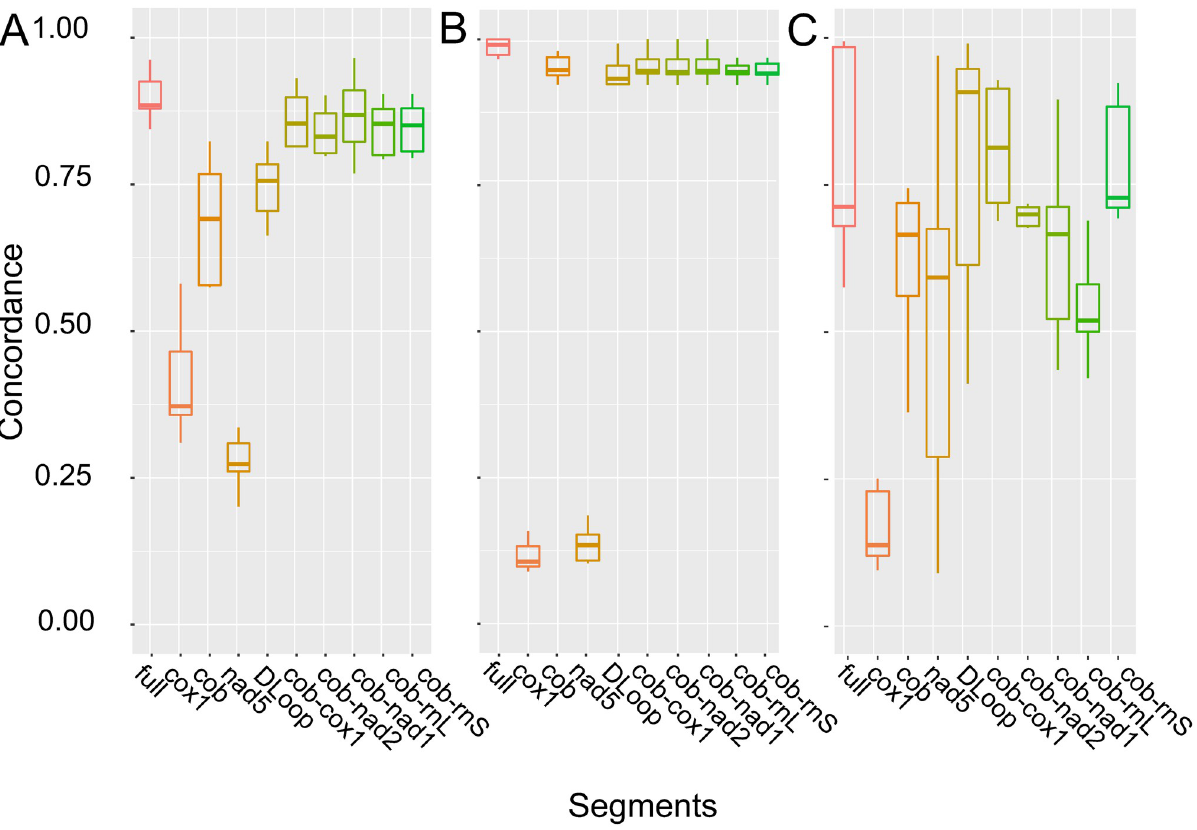
Fig 8. Concordances of the phylogenetic trees constructed based on full-length mtDNA and partial mtDNA sequences of (A) A . agrarius , (B) P . troglodytes , and (C) U . arctos . The phylogenetic trees of the complete and partial mtDNA of the randomly selected sequences of each organism were constructed, and the concordances of these trees to the one constructed on the entire dataset of complete mtDNA are indicated as box-and-whisker plots. cob - cox , cob - nad 2, cob - nad 1, cob - rnL , and cob - rnS are the contiguous segments spanning through the D-loop region and contain the entire sequences of cob and indicated genes at the